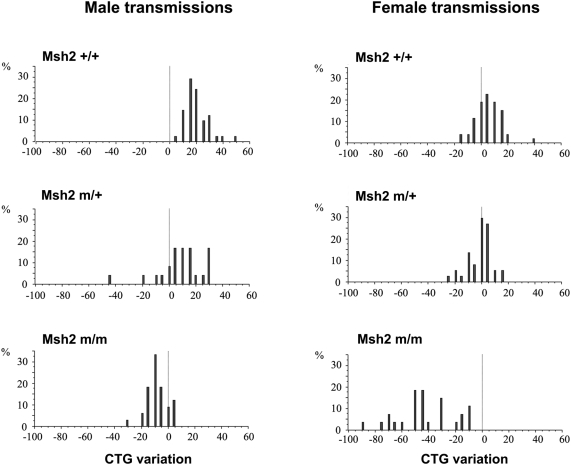
Intergenerational instability of CTG repeat in Msh2G674A mutant and wild-type mice.The x-axis shows CTG repeat length changes and the y-axis the percentage corresponding to each size changes for all transmissions analysed. Genotypes of parent and offspring are indicated on the left of each graph. For male transmissions, the transmitting progenitors were aged 14–52 weeks and carried an expanded trinucleotide sequence varying 395 to 563 CTG repeats. For female transmissions, the transmitting progenitors were aged 10–40.5 weeks and carried an expanded trinucleotide sequence varying from 401 to 647 CTG repeats.